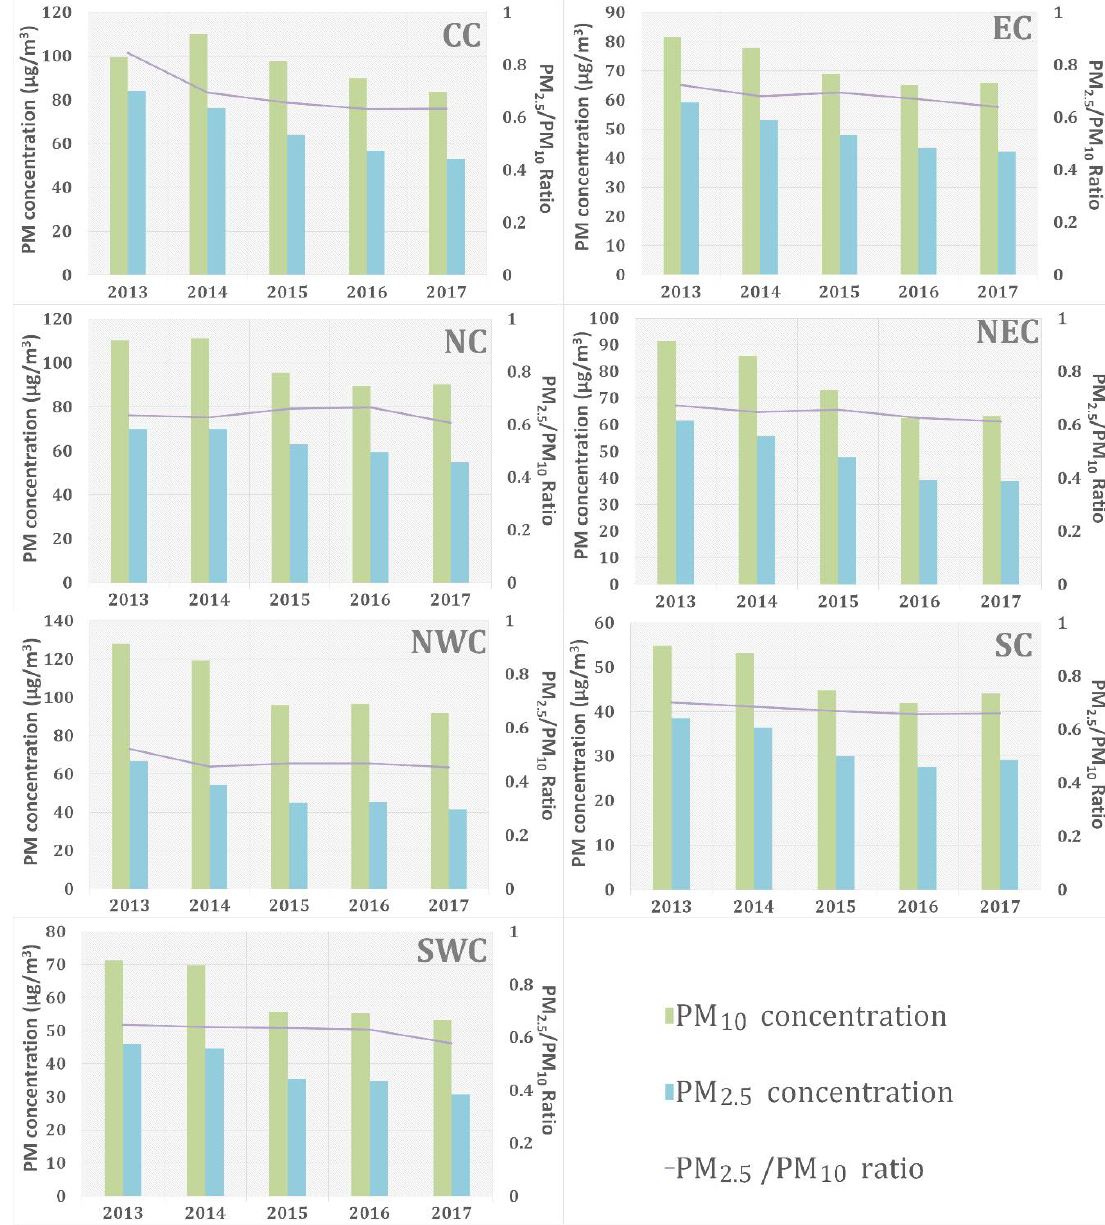
Figure 6. The 5-year variations of PM 2.5 /PM 10 Ratio and Difference Value (PM 10 –PM 2.5 ) in each region of study area.